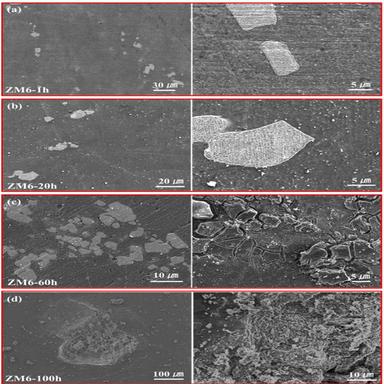
SEM (a–d) surface and (e) cross-sectional morphologies and (f) XRD patterns of ZM6 alloys after oxidation for 1 h, 20 h, 60 h, and 100 h.